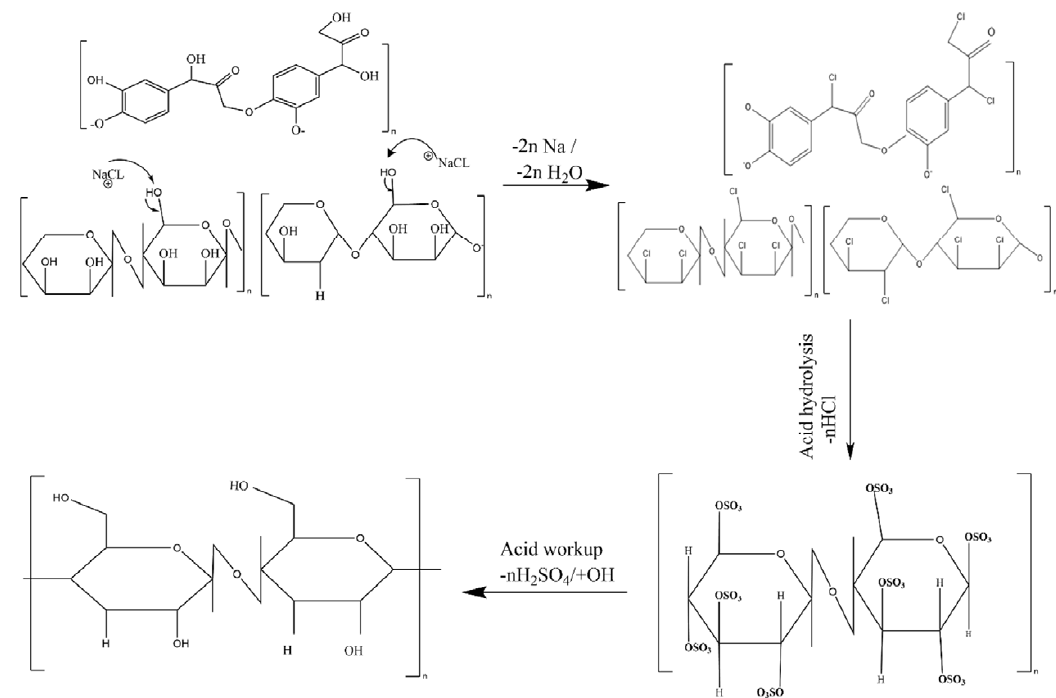
Fig. 3. Mechanism of Nanocellulose